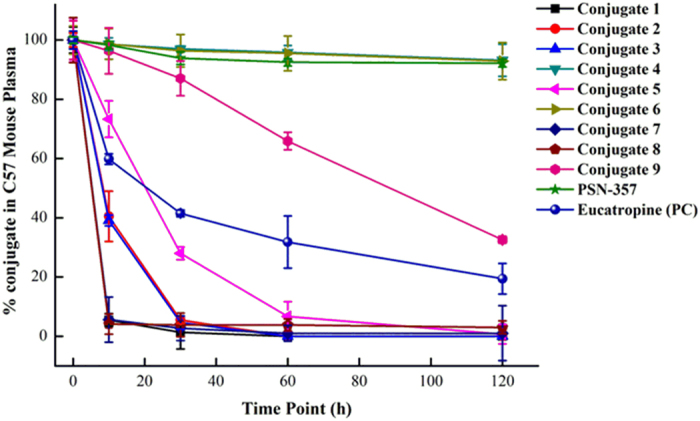
Time-course of mouse plasma stability for conjugates 1–9 (n = 3).